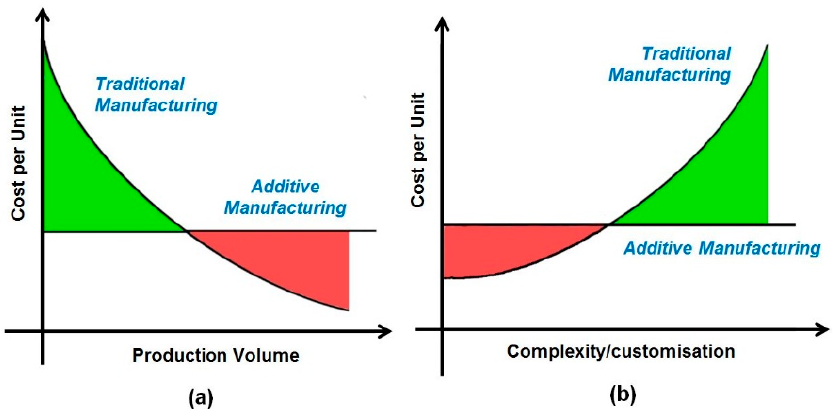
Figure 12. Cost and complexity comparison between ( a ) 3D printing (additive manufacturing) and ( b ) traditional manufacturing [85].